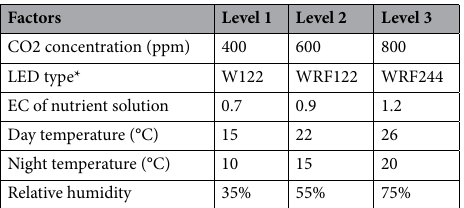
Table 2. The selected factors and levels for designing an experiment using Taguchi method in the present study. * W white, R deep red, F far red, 122 and 244 indicate the amount of PPFM.